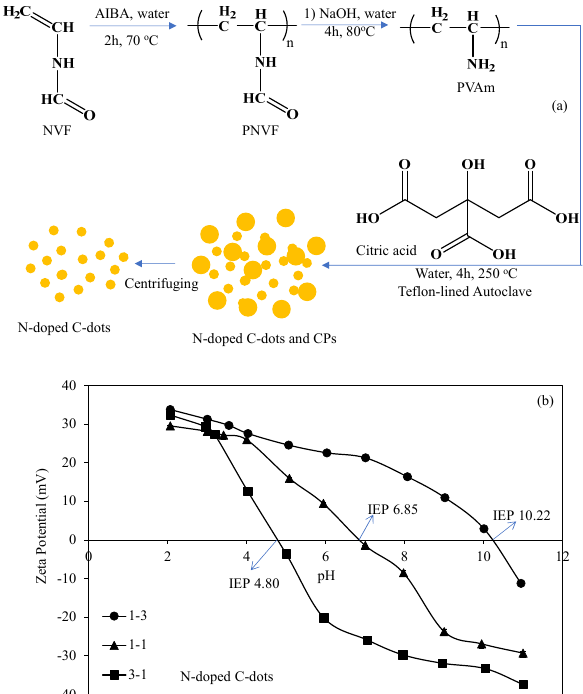
Figure 1. ( a ) The schematic presentation of the synthesis process of Ndoped C-dots and CPs and ( b ) pH vs. Zeta potential measurements of N-doped C-dots.